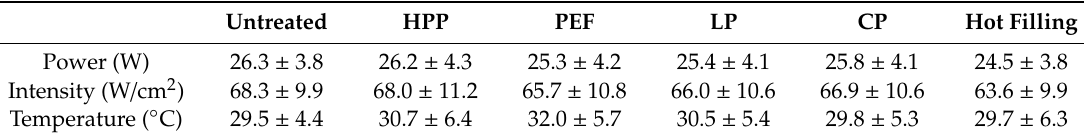
Table 2. Process parameters (powers, intensities, and temperatures) of the ultrasound treatments at an amplitude of 80% for 12 min. Values are means ± standard deviation of process parameters given by the ultrasound instrument every 10